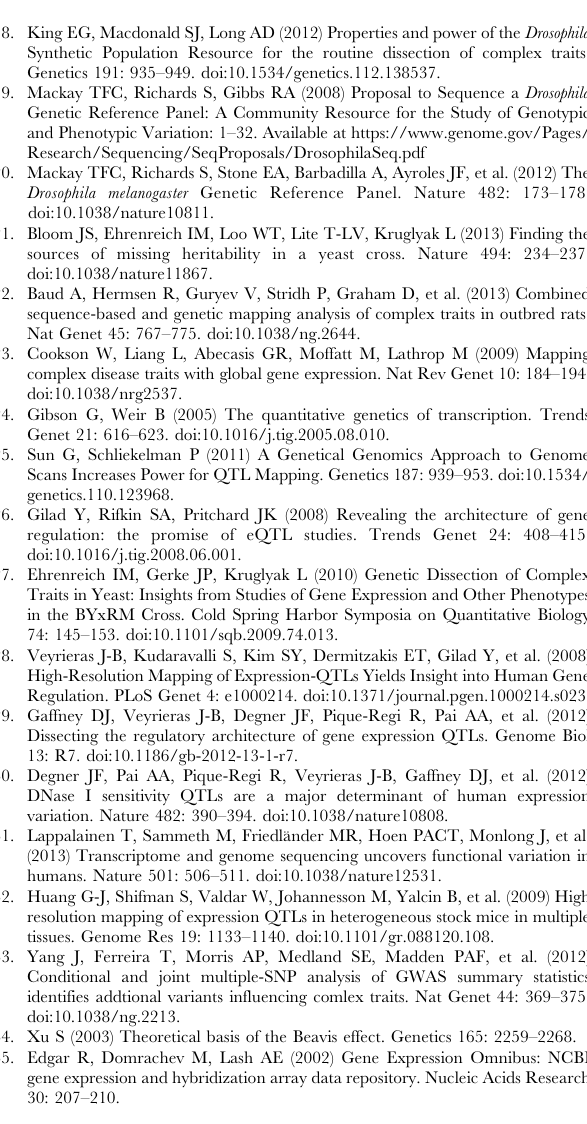
Table S2 Sensitivity of the minimum P-value and AIC method of estimating different alleles for different simulation models. For each, the probability of estimating 2 or more alleles given a true value of 2 or more alleles is displayed. Table S3 Hard coded founder genotype assignments at all significant eQTL. Each RIL at each eQTL peak is assigned the most likely founder genotype, given the probability is greater than 0.95. This corresponds to a 2 digit number with the assignment from the population A RIL and the population B RIL. E.g. the number 24 indicates that RIL cross has an A2B4 genotype. If the highest founder genotype probability is less than 0.95 it is coded as uncertain. The number 9 indicates an uncertain